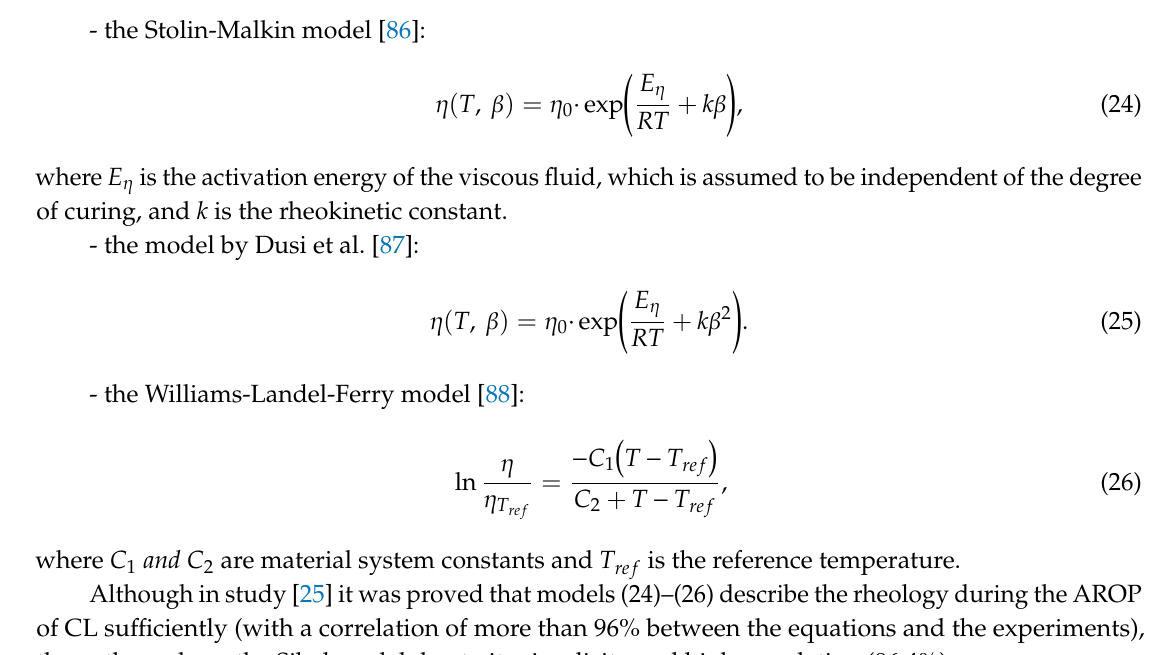
1. The reaction time (required for the complex viscosity level of 10 3 Pa · s) for the examined reactive mixture was extremely short: 90 s at 120 ◦ C 45 s at 160 ◦ C. 2. Below 50% conversion, complex viscosity can be described by the Sibal model: η The isoviscosity curves vs. time and temperature were obtained for the AROP of CL. The obtained viscosity data was used to determine constants of the modified Castro-Macosko